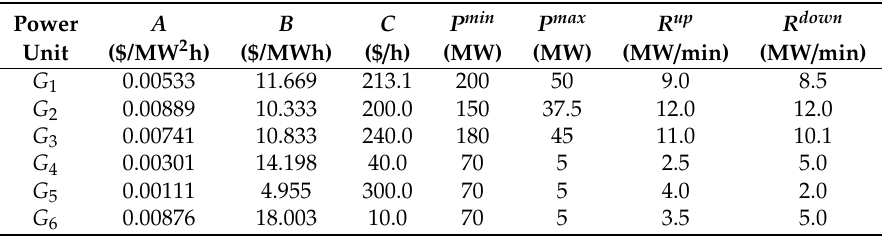
Table 1. Power generation technical